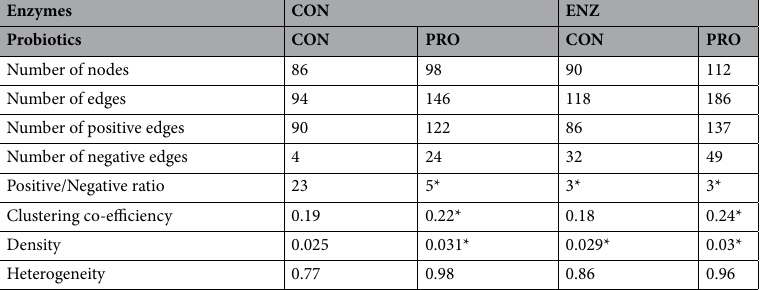
Table 4. The characteristics of the networks from each dietary group. CON, no supplementation; ENZ, enzyme supplementation; PRO, probiotic supplementation. *Stars indicate significant differences from the CON-CON treatment at P < 0.05, after performing the permutations analysis (70% of the initial